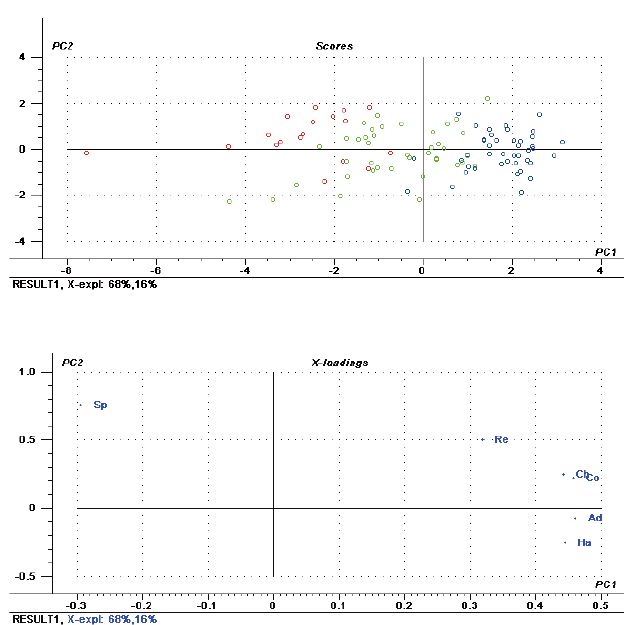
FIGURE 5 - (A) PCA score plot of the physical properties of wet masses for type ① ( ⃝ ), type ② ( ⃝ ) and type ③ ( ⃝ ). (B) PCA loading plot of the physical properties of wet masses.